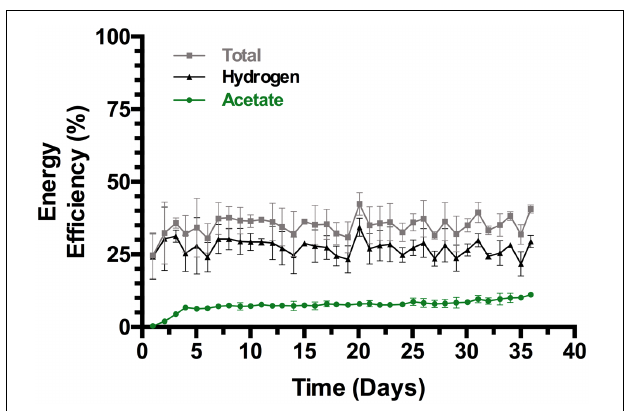
FIGURE 4 | Energy efficiency of triplicate bioelectrochemical reactors (SD, n = 3).